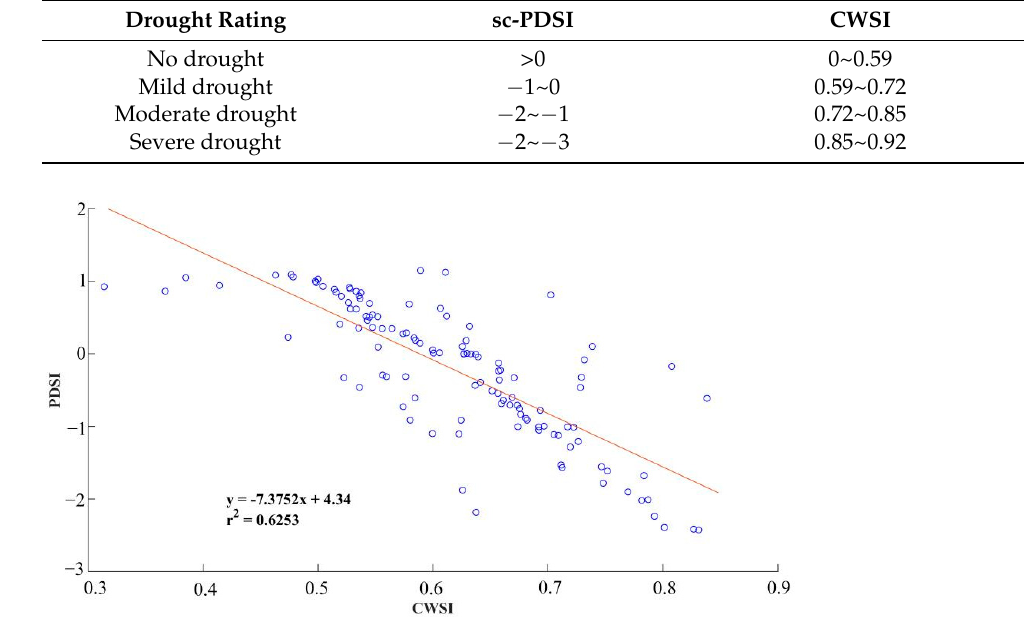
Figure 5. Linear regression analysis of PDSI and CWSI in the Sichuan Province from 2001 to